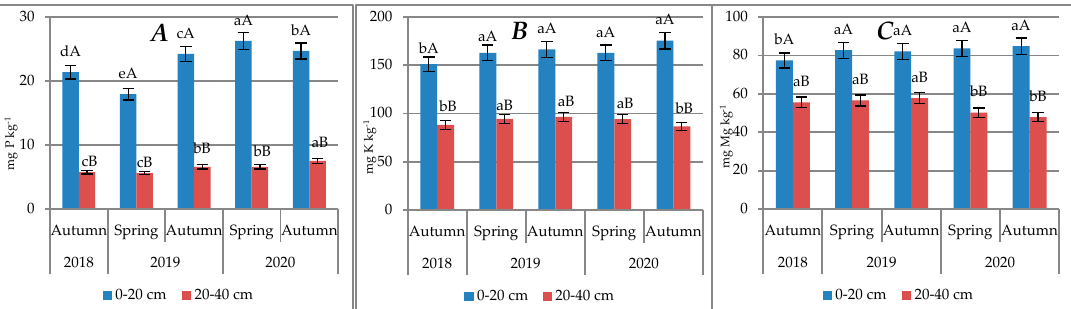
Figure 2. ( A – C ). Contents of available P ( A ), K ( B ), and Mg ( C ) in the studied soil. Different lower- case letters indicate significant differences among the soil sampling seasons (2018 autumn, 2019 and 2020 spring, autumn). Different upper-case letters indicate significant differences among the levels of sampling. Error bars represent standard deviation.